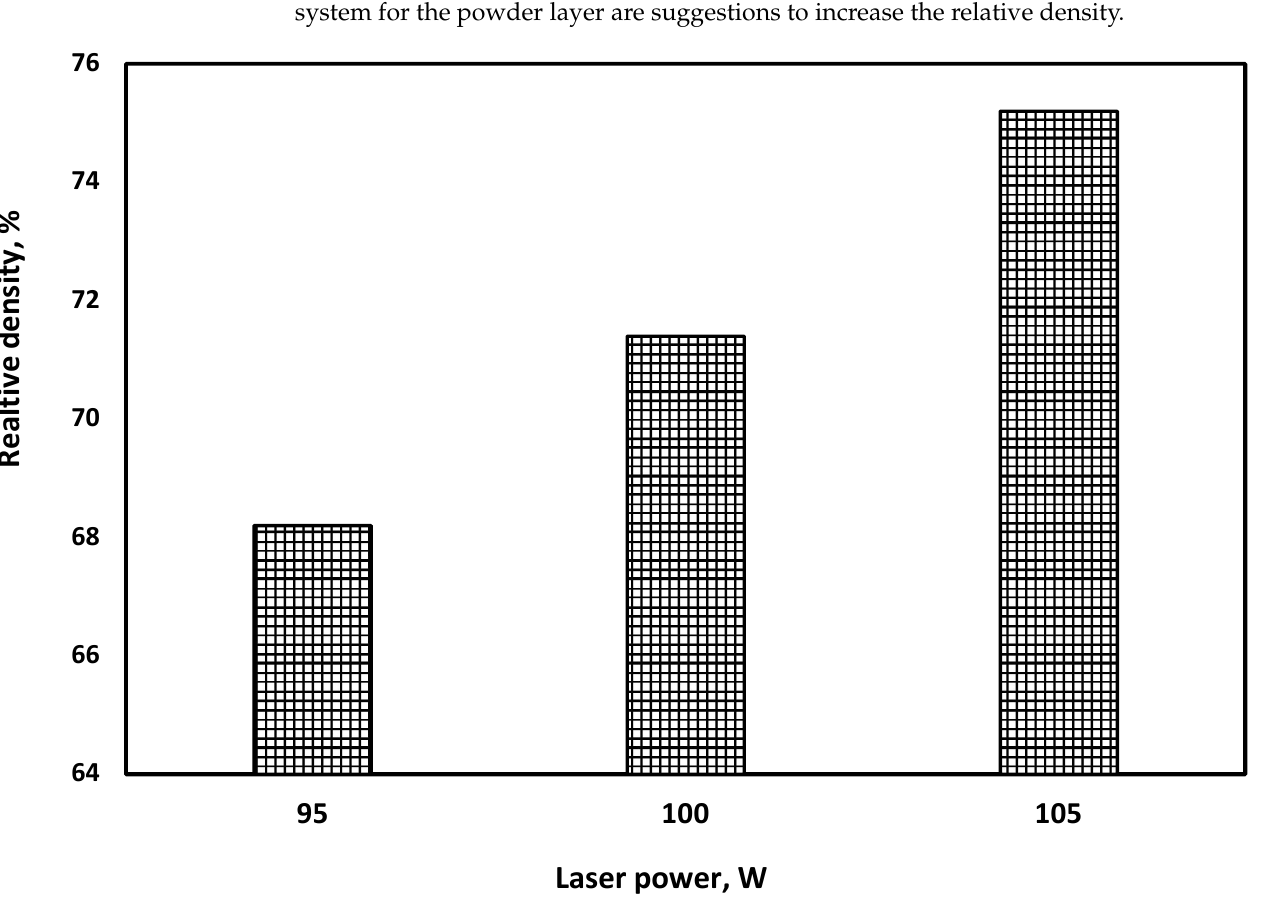
Figure 8. Alumina samples’ relative density results.